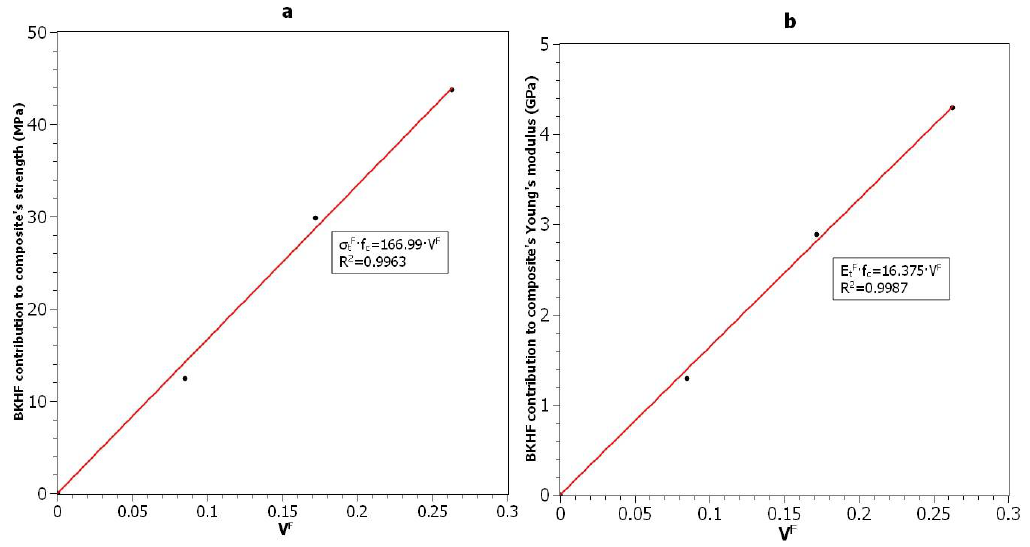
Figure 5. Net contributions of the reinforcement to the ( a ) tensile strength of the composite and ( b ) Young’s modulus of the composite. ( b ) Young’s modulus of the